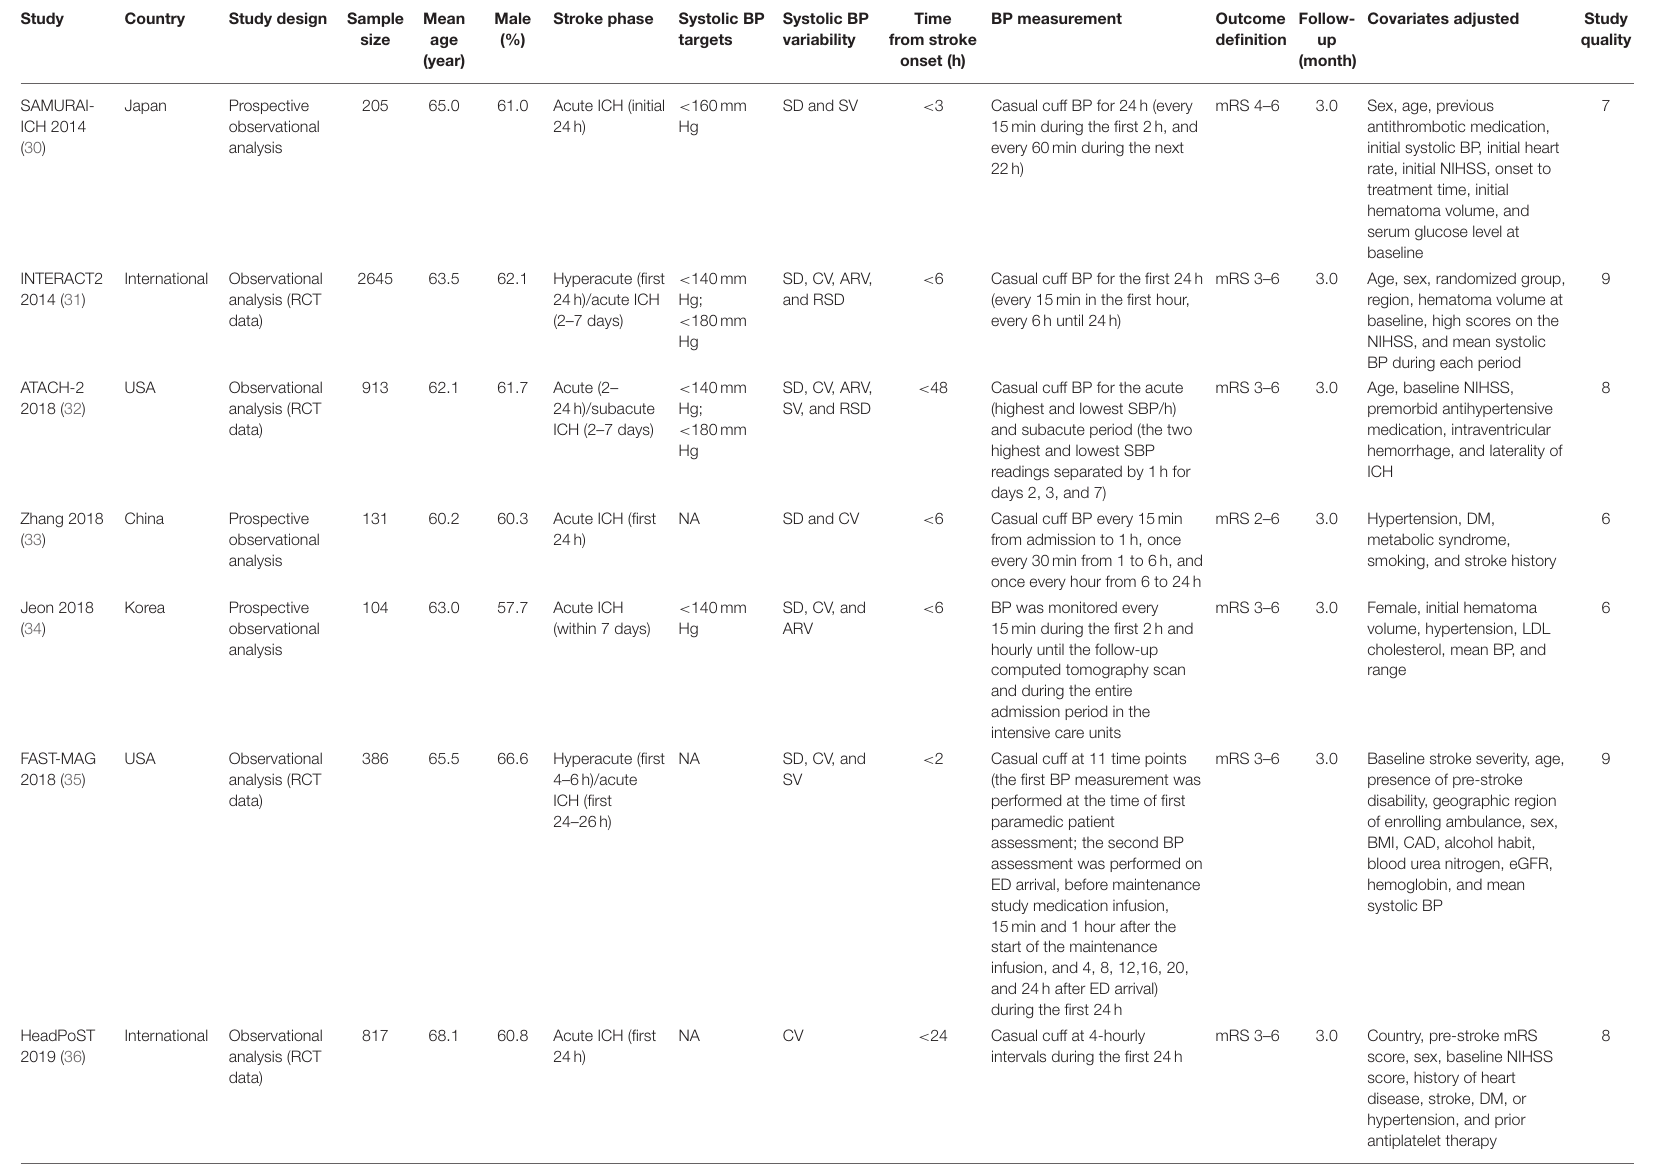
TABLE 1 | Characteristics of studies and patients